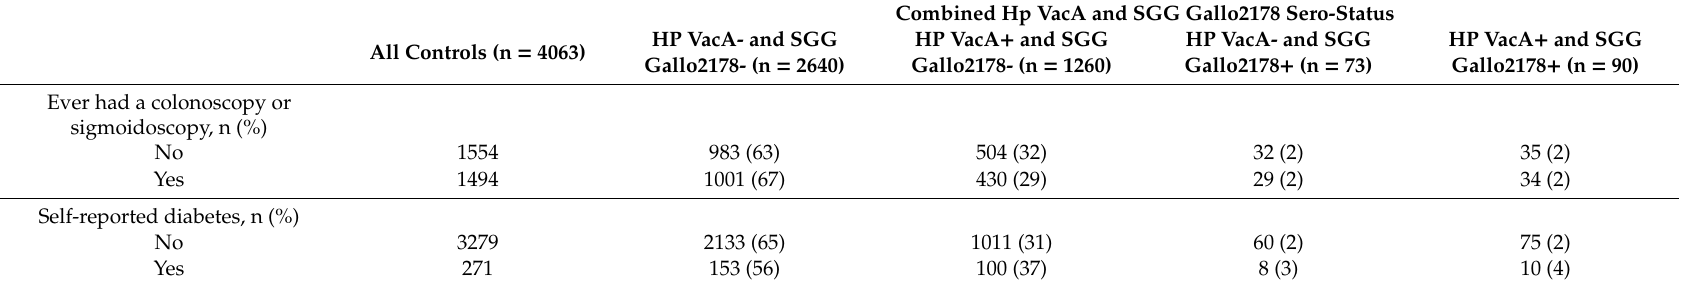
Combined Hp VacA and SGG Gallo2178